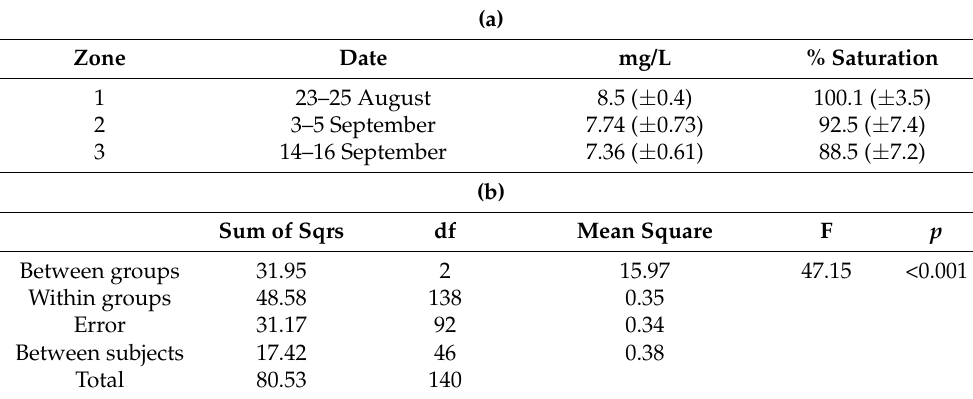
Table 3. (a) Mean ( ± SD) values of dissolved oxygen measured in the three zones of the cave. (b) Results of analysis of variance (ANOVA) on repeated measures of dissolved oxygen in the three zones of the cave.